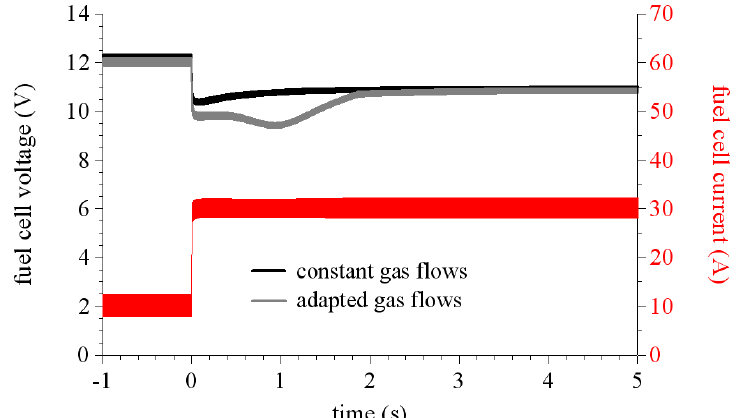
Figure 12. Simulated responses to a 10 A/30 A current step of a fuel cell stack connected to a regulated boost